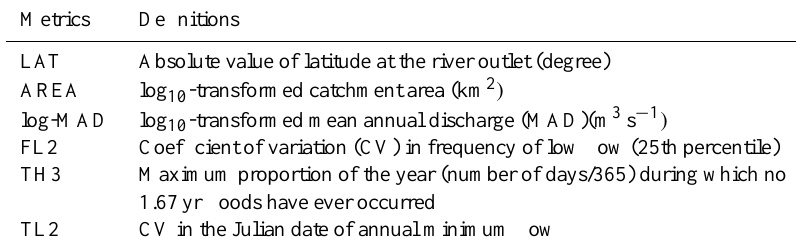
Table 1. List of flow metrics and definitions used in the FSR-FLVAR